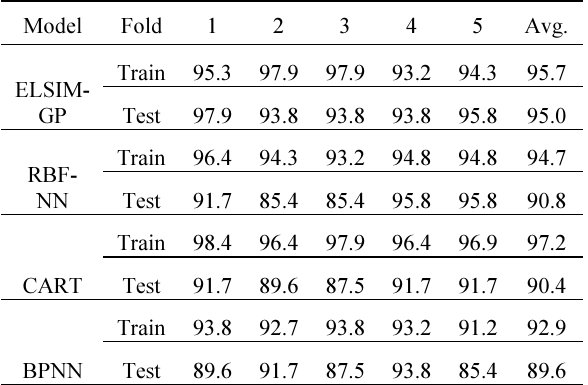
Table 5. Comparison of classification accuracy ( % ) Model